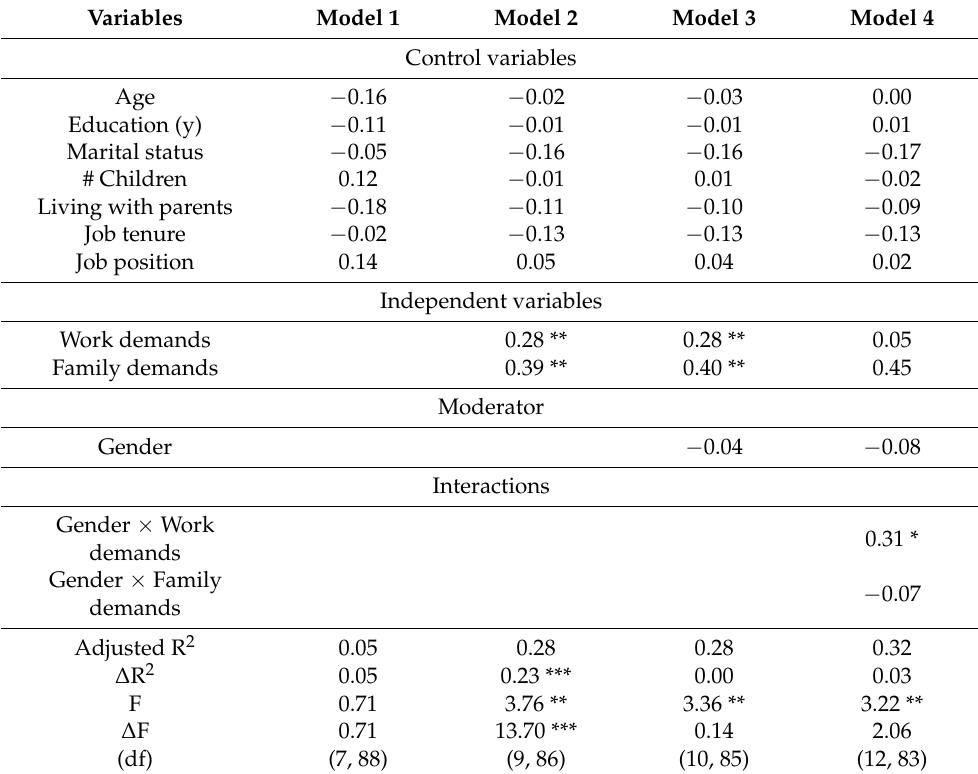
Table 5. Interactive effects of gender and work and family demands on family-to-work conflict among egalitarian men and women (N = 102).